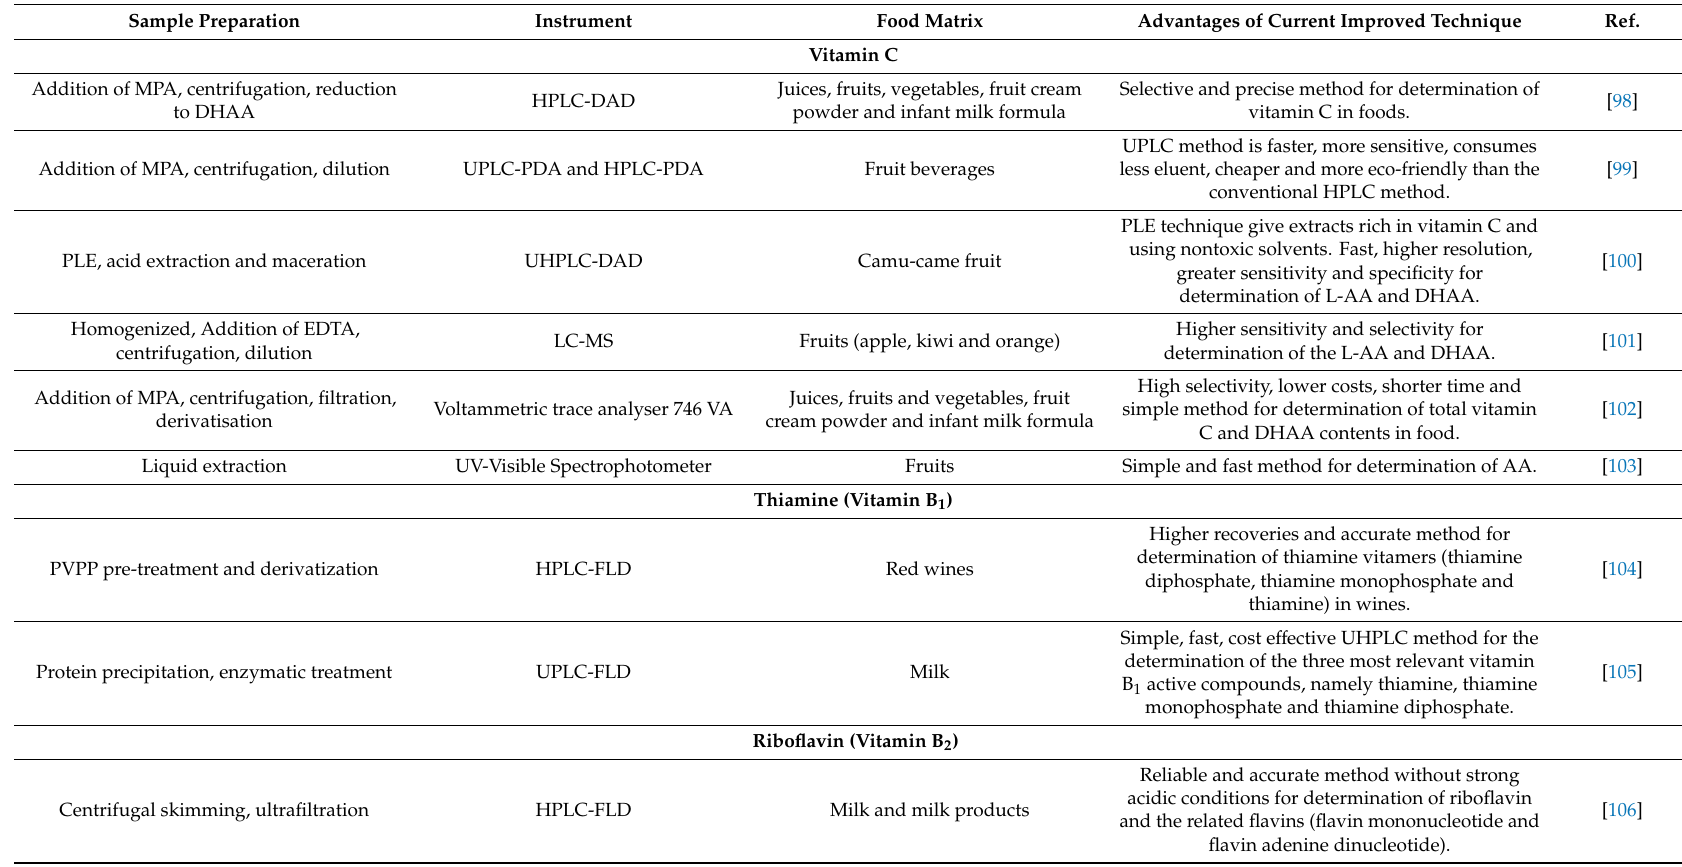
Table 4. Methods, food matrices and advantages of current improved technique for water-soluble